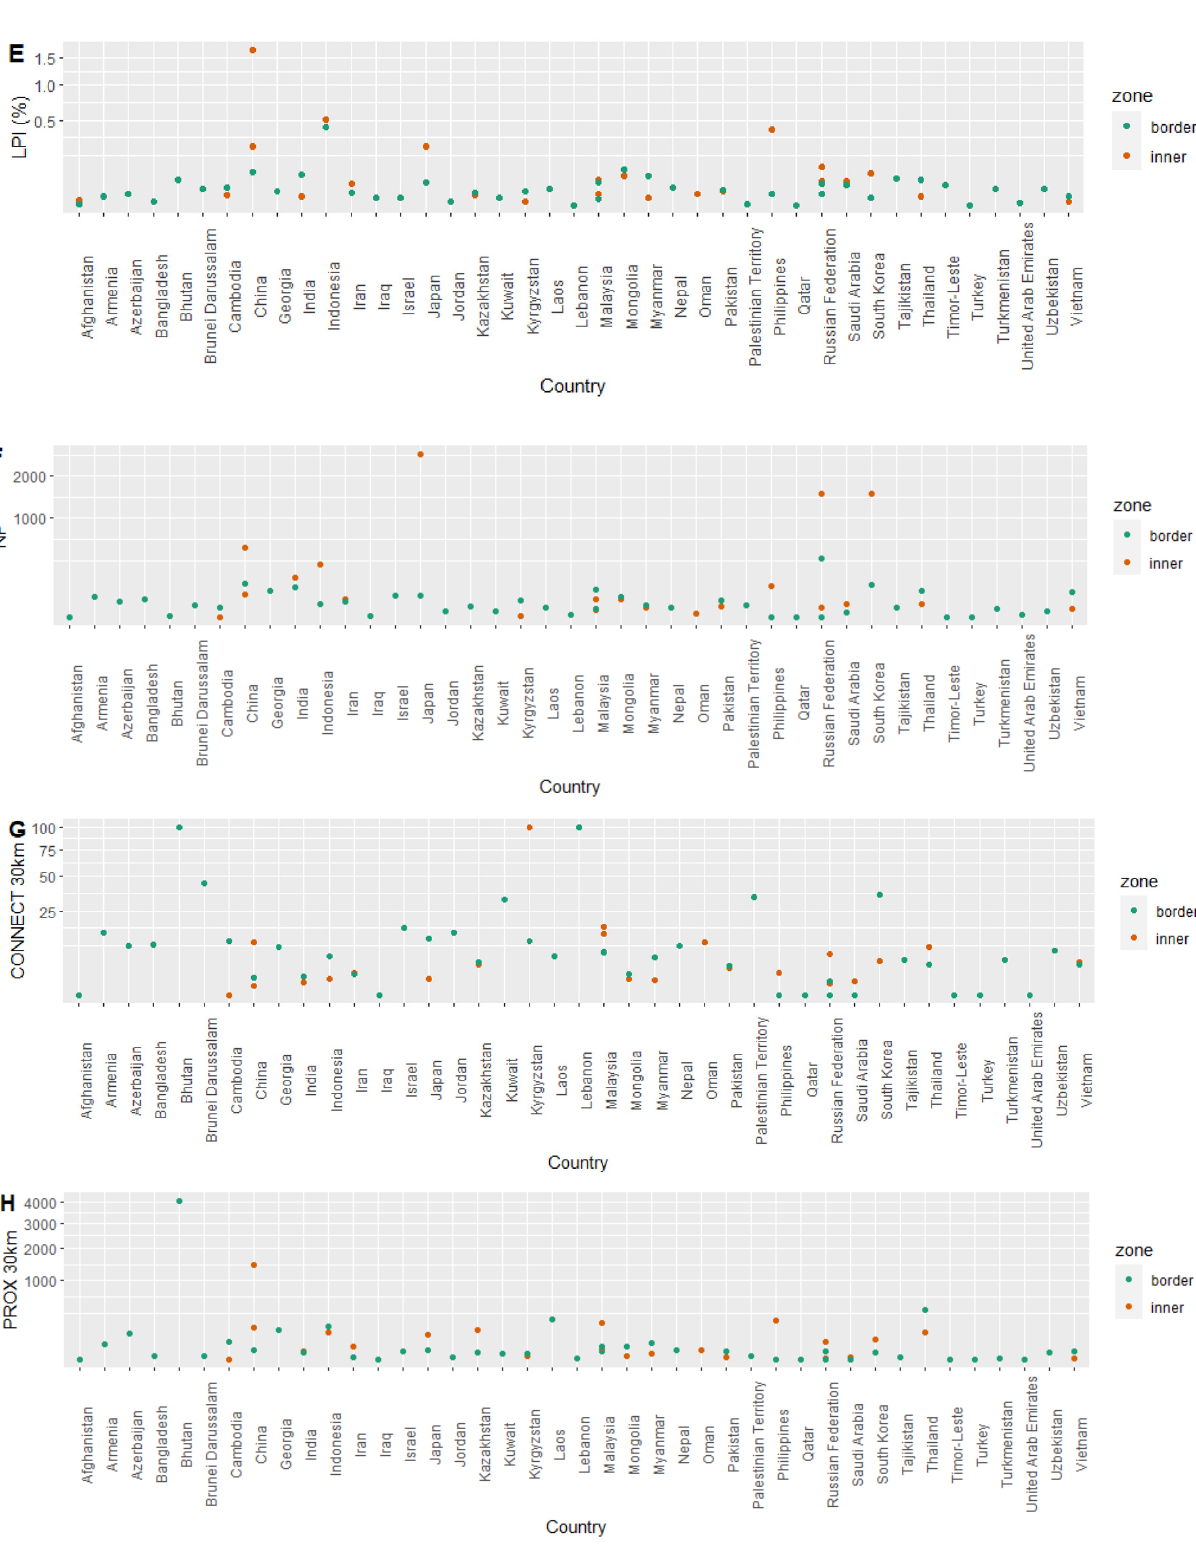
Figure 5. Country-level analysis of connectivity metrics. ( A ) Area-weighted mean patch radius of gyration (GYRATE_AM); ( B ) Area-weighted mean patch area (AREA_AM); ( C ) Edge Density (ED); ( D ) Percentage of landscape (PLAND); ( E ) Largest patch index (LPI); ( F ) Number of Patches (NP); ( G ) Connectance index (CONNECT) 30 km; ( H ) Proximity index (PROX) 30